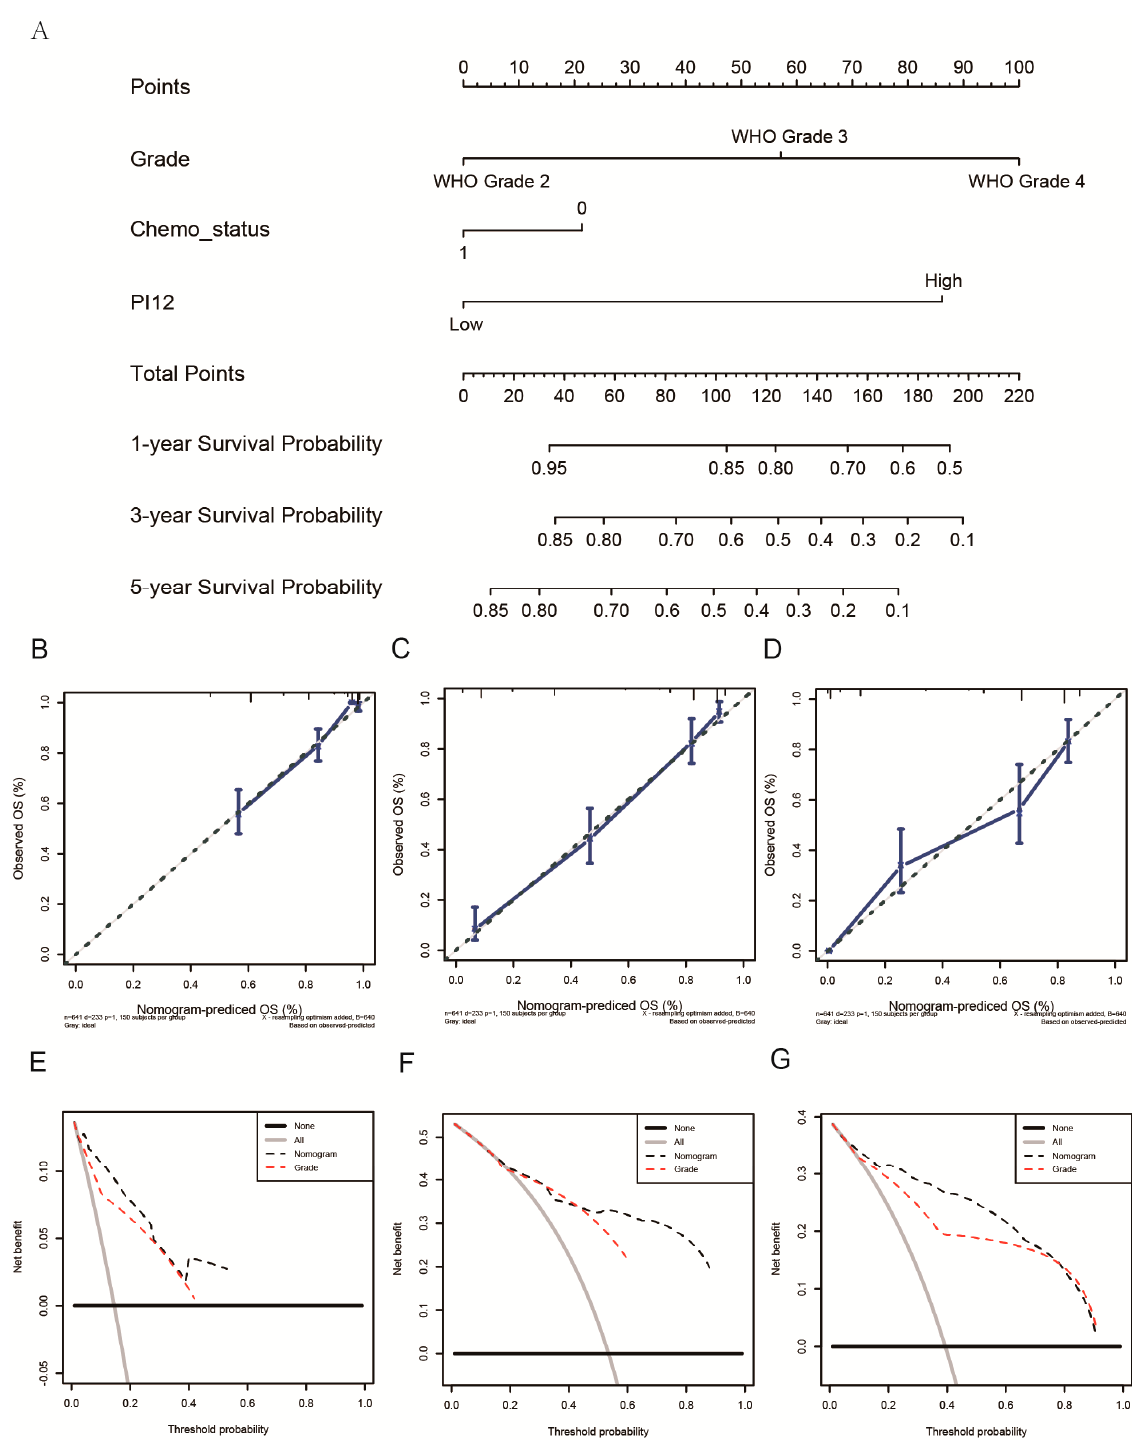
Figure 11. Construction and validation of a nomogram. ( A ) The nomogram predicting 1 − , 3 − and 5 − year survival. ( B – D ) Calibration plots of the nomogram showed that the predicted 1 − , 3 − and 5 − year survival probabilities of the validated cohort for OS were almost identical to the actual observations. ( E – G ) Decision curve analysis from the validation set for 1-, 3- and 5-year survival.